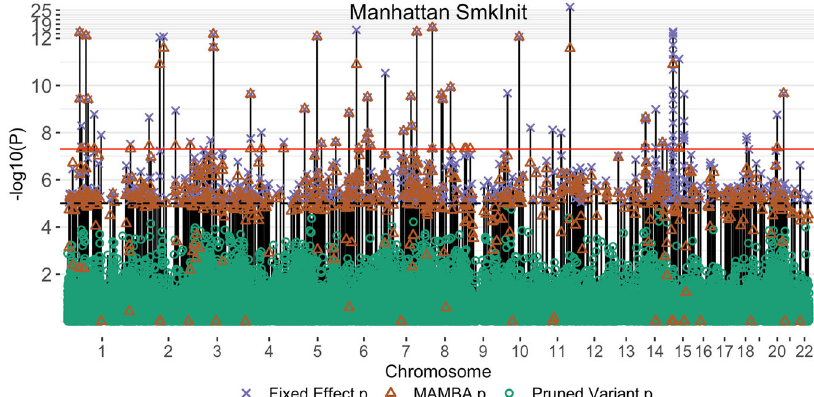
Fig. 3 Layered Manhattan plot for smoking initiation (SmkInit) phenotype. Each vertical line represents a SNP analyzed by the MAMBA, where the line extends to a purple cross indicating the fi xed-effects p -value. Orange triangles on the same line indicate the MAMBA p -values for the same SNP. Green points are the p-values for randomly pruned markers included in the MAMBA model to ensure that both non-replicable and replicable associations are incorporated. P -values for the MAMBA model were calculated through a bootstrap procedure. All p -values are two-sided and not adjusted for multiple comparisons. Source data are provided as a Source Data fi le.